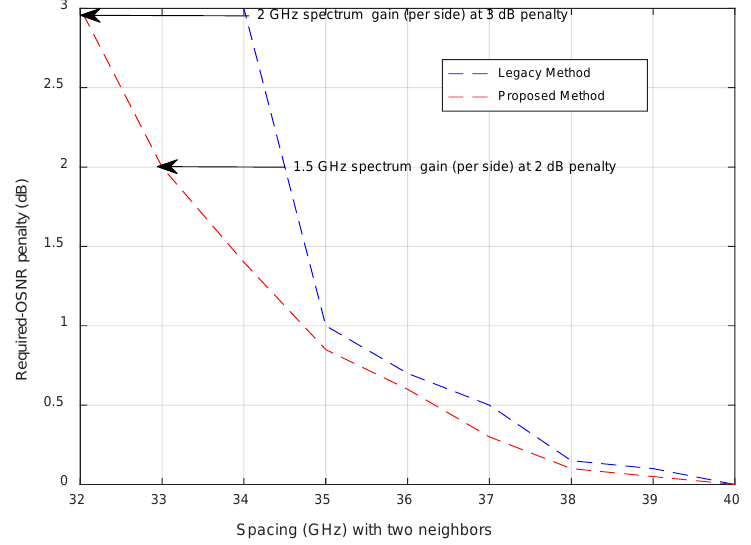
Figure 12. Results showing the advantage of the proposed optimization